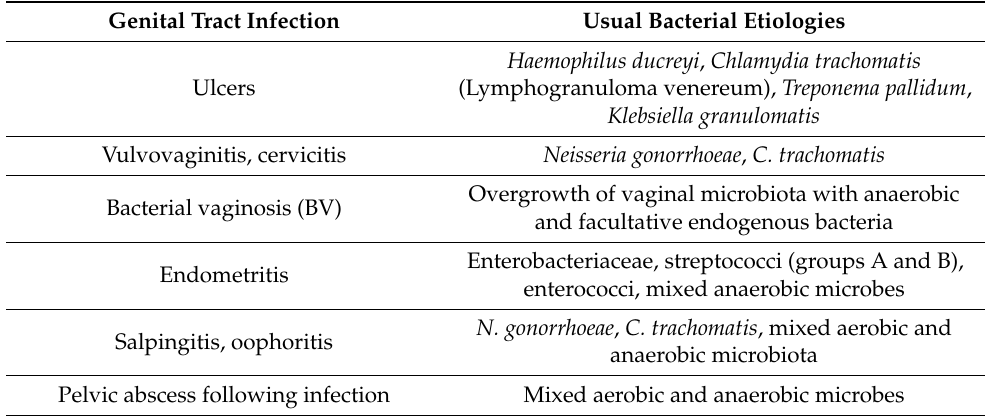
Table 1. Genital tract morbidities and their bacterial